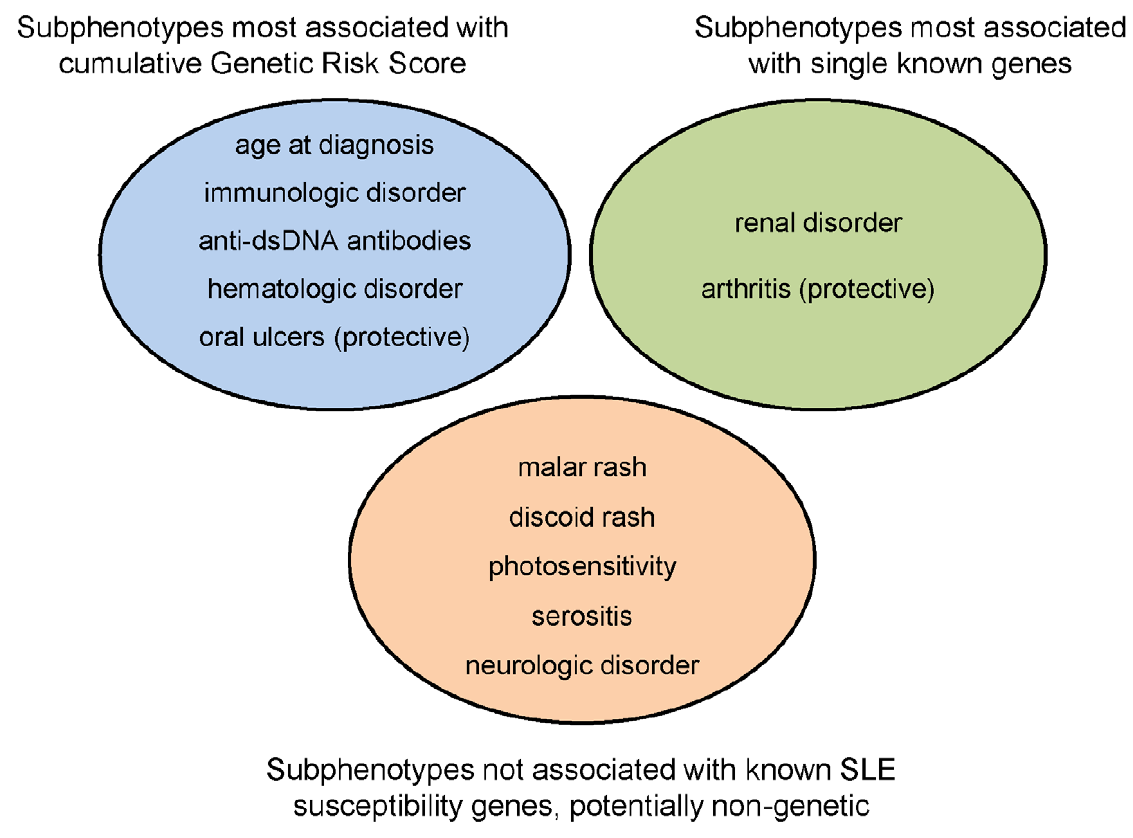
Figure 4. Categorization of SLE subphenotypes by strongest association with currently known susceptibility loci: genetic risk score, single locus, or none.